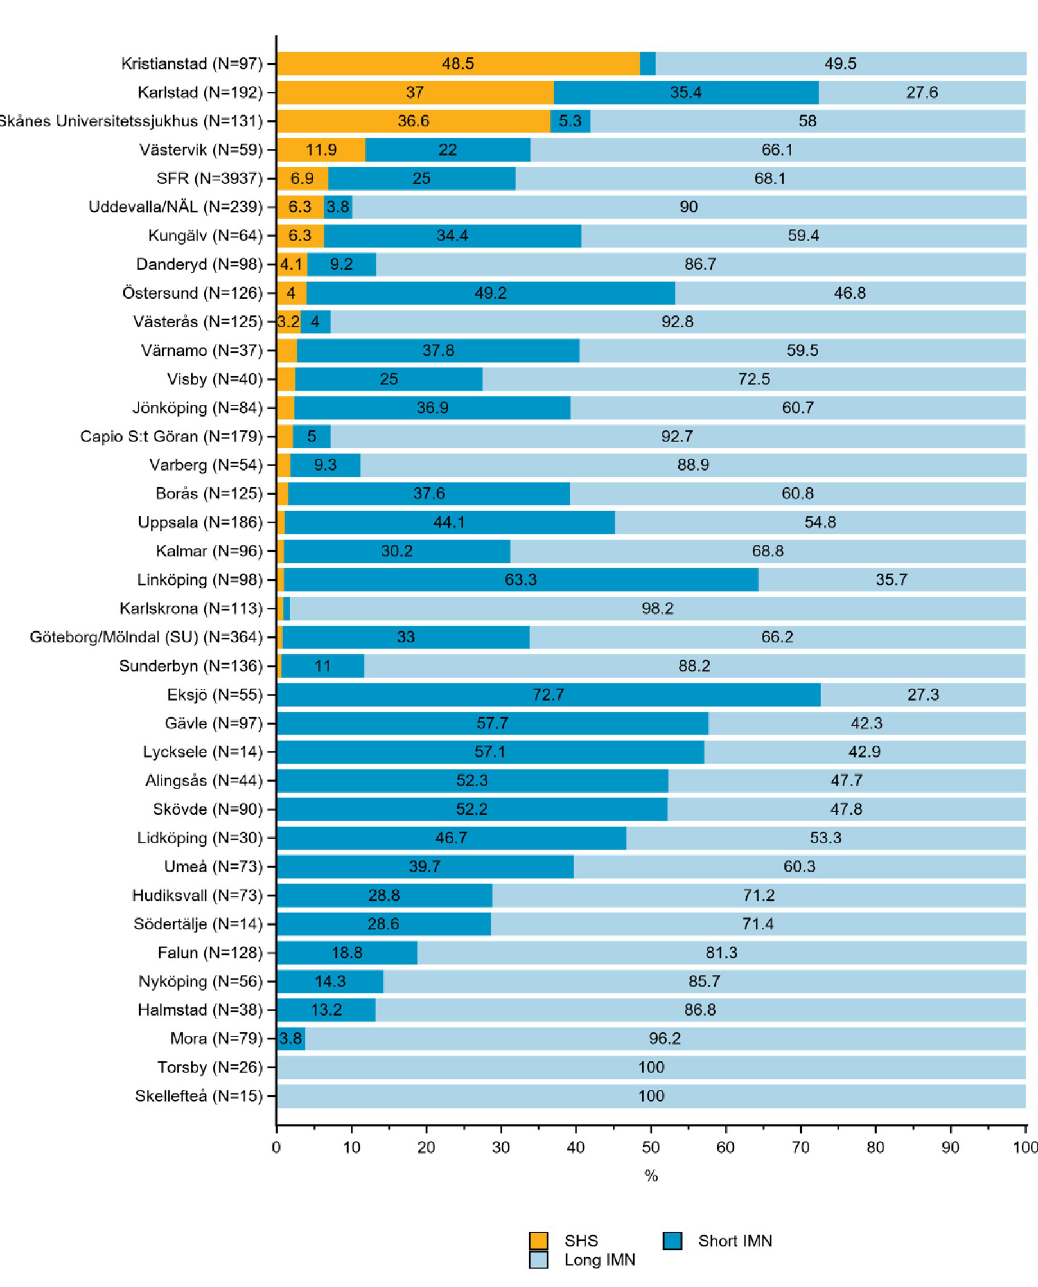
Fig 4. Distribution of sliding hip screw (SHS), short and long intramedullary nail (IMN) in the treatment of A3 trochanteric hip fractures by department in the Swedish Fracture Register in 2016–2020. SFR denotes all registrations in the Swedish Fracture Register (distributions are nationwide